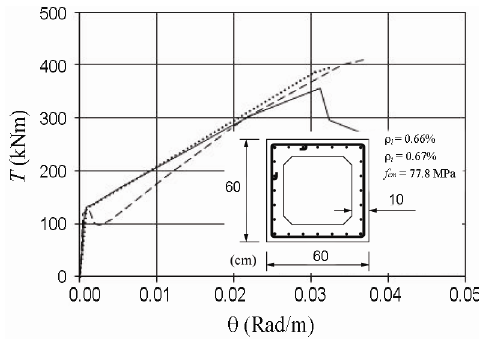
Fig. 12. T – θ curves for Beam B2